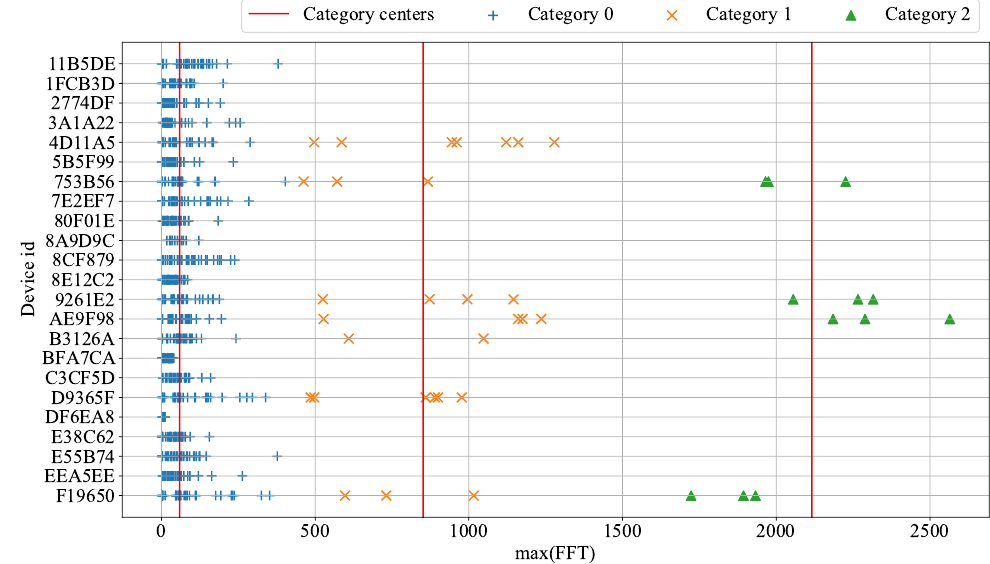
Figure 25. Categories center of max(FFT) clustering result.